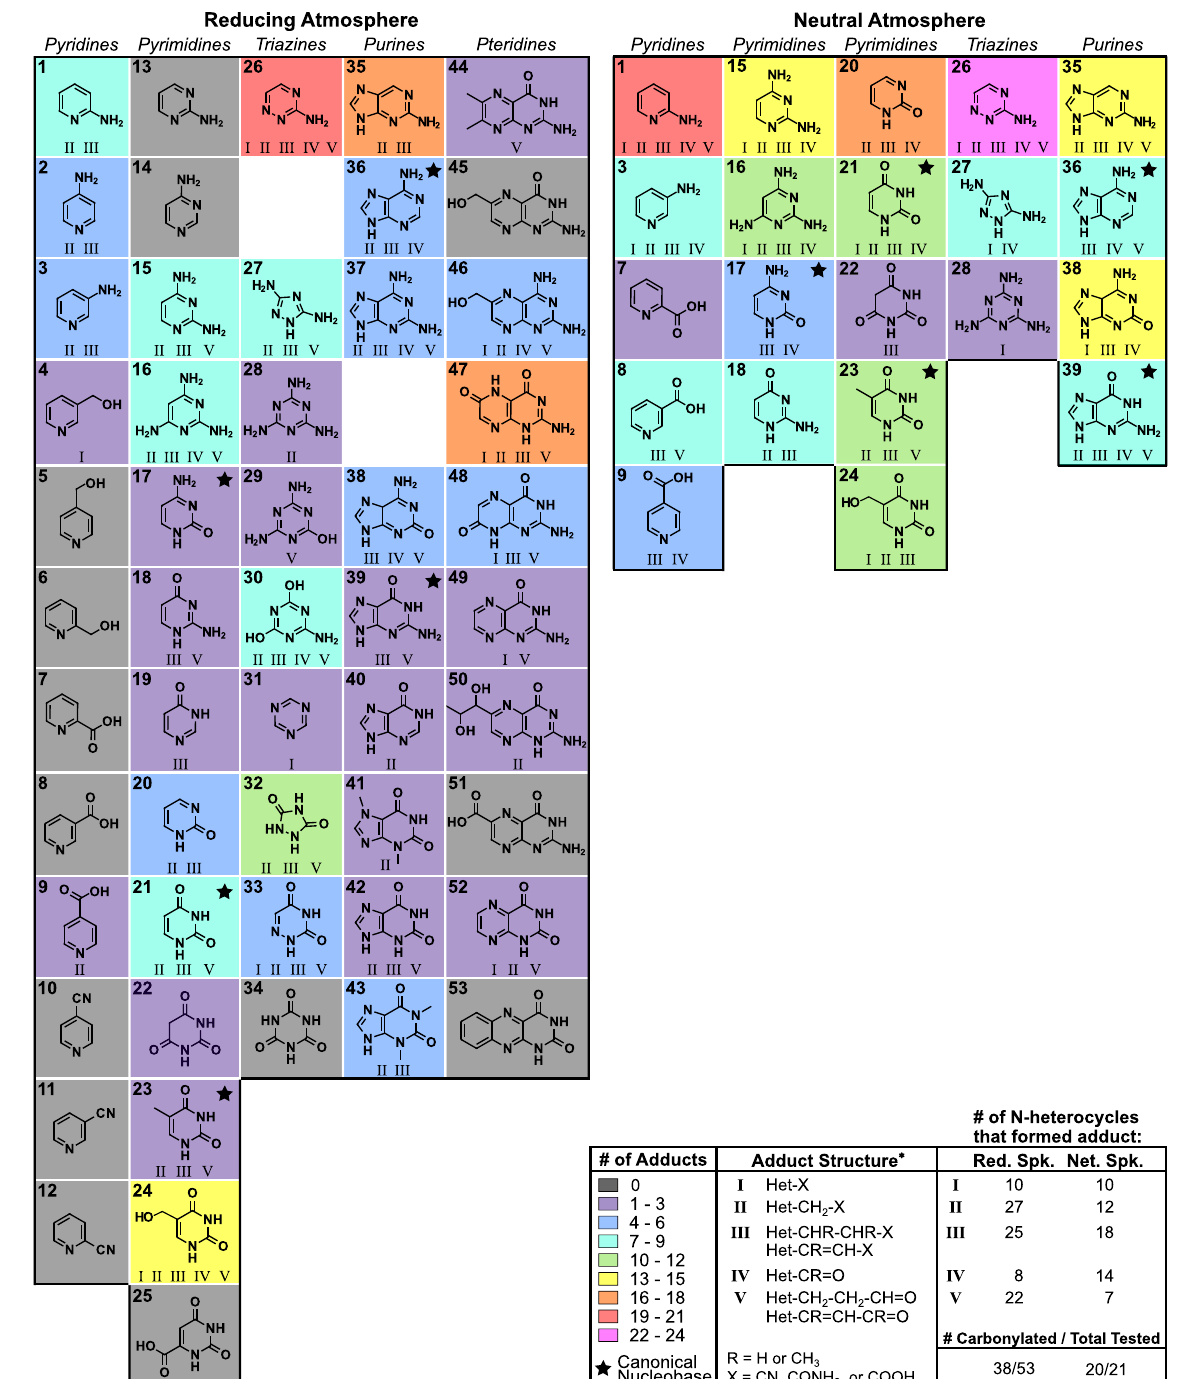
Given that almost all the N-heterocycles with carboxylic acid groups were unreactive under a reducing atmos- phere, we were intrigued to find that all three pyridine carboxylic acids tested were reactive [ 7 , 8 , 9 ], with [ 8 and 9 ] forming carbonylated heterocycles; 2-pyridinecarboxylic acid [ 7 ] formed a single adduct containing an alcohol